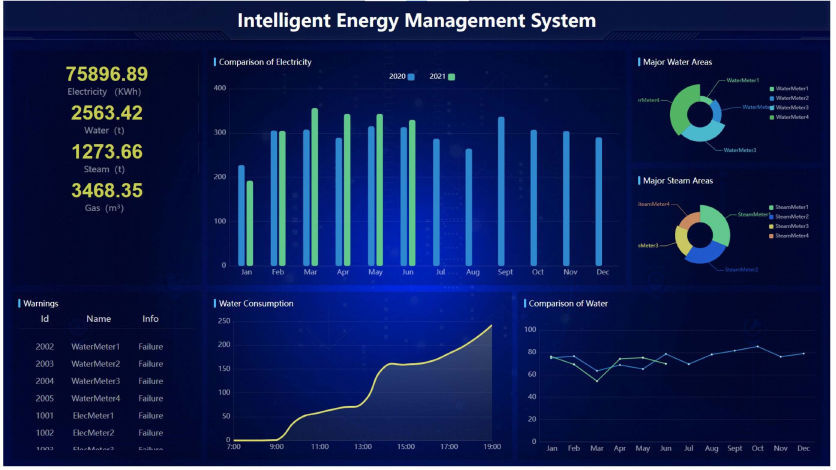
Figure 6. The large-screen display